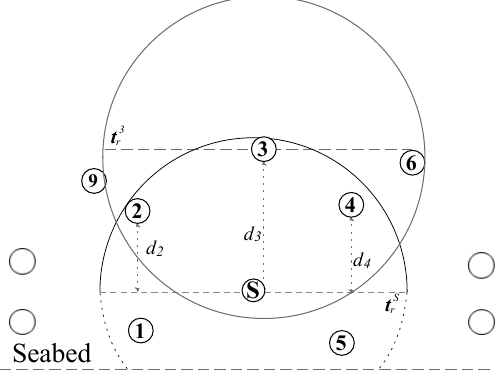
Figure 2. Depth based routing